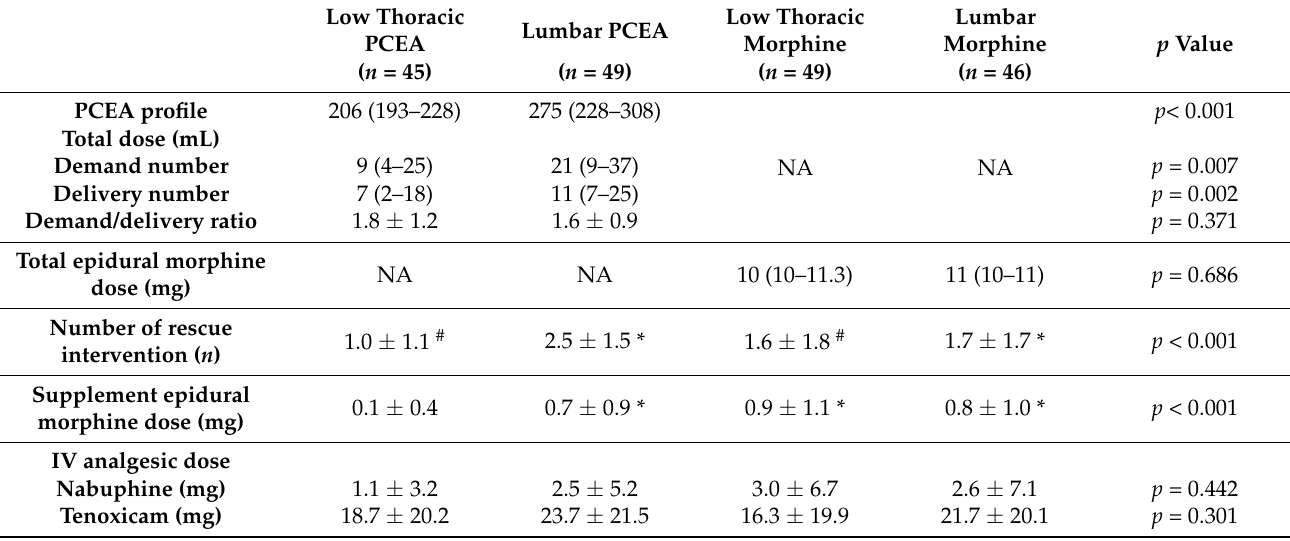
Table 4. Analgesic